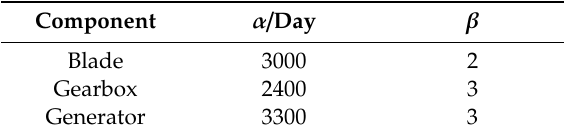
Table 4. Weibull distribution parameters for major components of wind turbines.